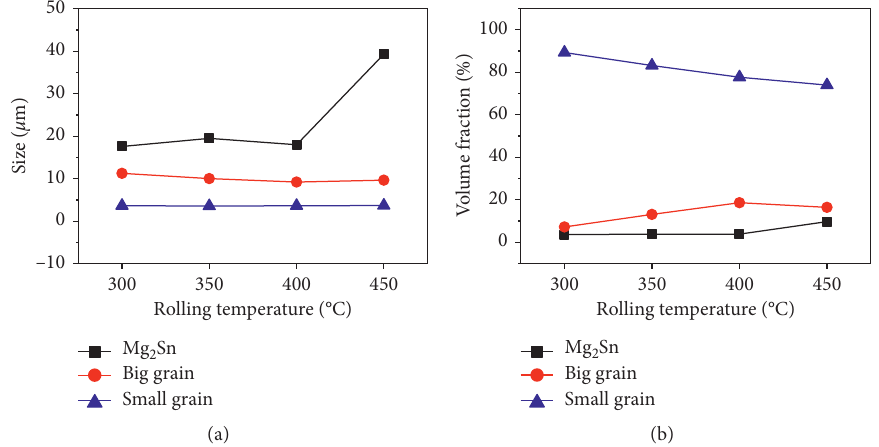
Figure 4: (a) The average grain size of small grains, big grains, and Mg 2 Sn phases of the alloys rolled at different temperatures. (b) The volume fraction of small grains, big grains, and Mg 2 Sn phases of the alloys rolled at different